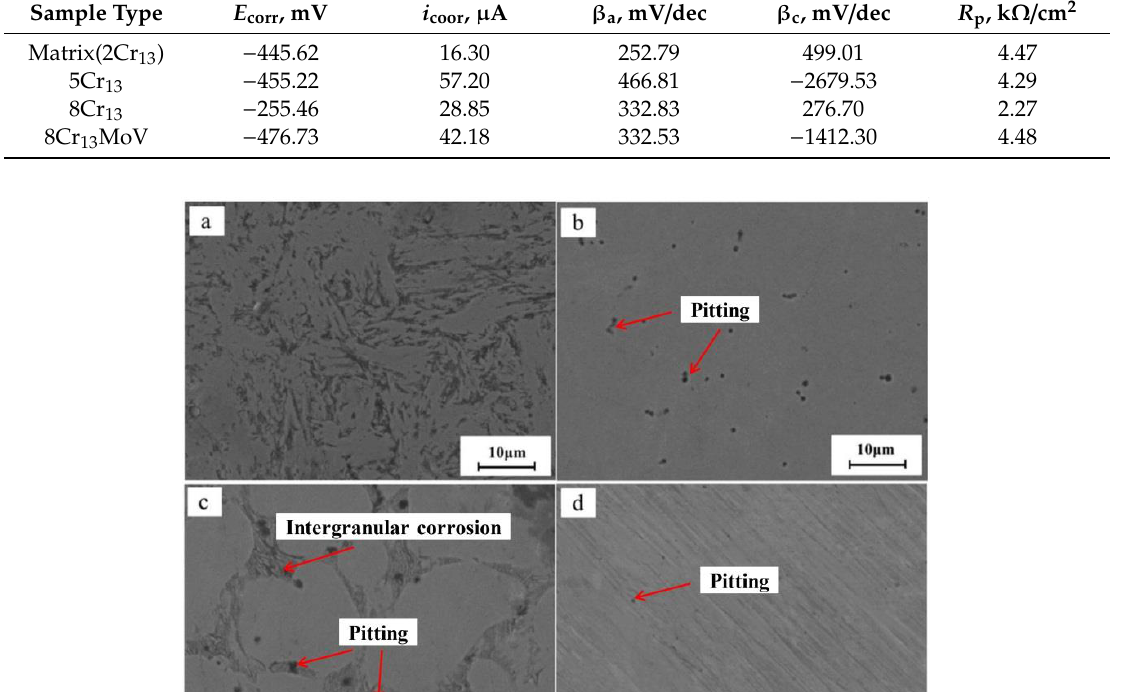
Figure 12. Electrochemical corrosion morphology. ( a ) matrix (2Cr13); ( b ) 5Cr13; ( c ) 8Cr13; ( d ) 8Cr13MoV.